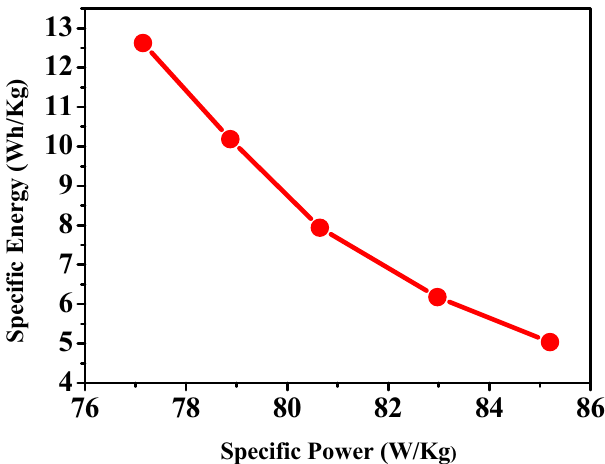
Figure 8. Ragone plot of P3HT /SWCNTs assembled nanocomposite supercapacitor